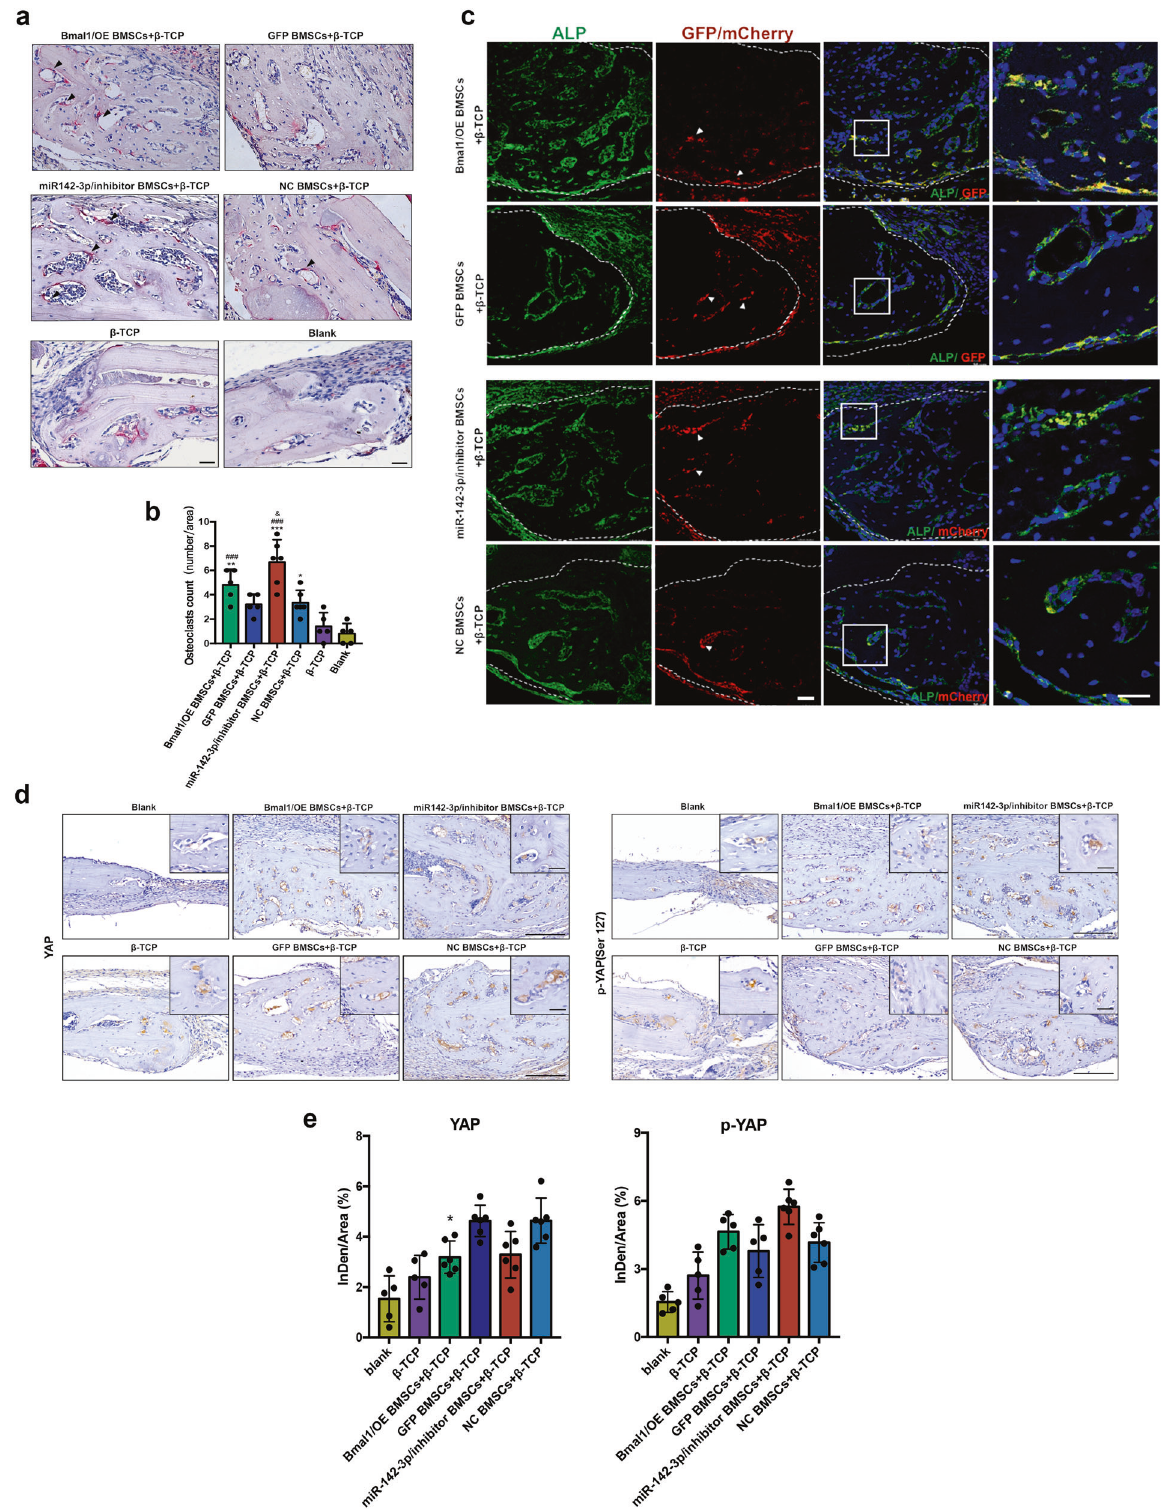
Fig. 6 High bone turnover activity and phospho-YAP level are present in Bmal1/OE and miR-142-3p/inhibitor BMSC-transplanted cranial defects in aged mice. a TRAP staining and quantitative analysis of the number of osteoclasts at transplanted defect sites; arrows indicate TRAP + cells. Scale bar: 25 μ m. b Quantitative analysis of in data a. c Double immunostaining images of ALP-expressing and GFP + or mCherry + cells, with nuclei stained with DAPI; arrows indicate GFP/mCherry + cells. Scale bar: 30 μ m. d Immunostaining images of p-YAP, YAP in cells transplanted defect sits. Scale bar: 100 μ m for 4x images, 25 μ m for 40x images. e Quantitative analysis of data in d. N = 5 – 6; Data are presented as mean ± SD; ( b ) * p < 0.05, ** p < 0.01, *** p < 0.001 compared with the blank group, ### p < 0.001 compared with β -TCP group, & p < 0.05 compared with the mock group by one-way ANOVA with Tukey ’ s post hoc test. ( e ) * p < 0.05 compared with mock group by one-way ANOVA with Tukey ’ s post hoc test. Cell Death Discovery (2022)